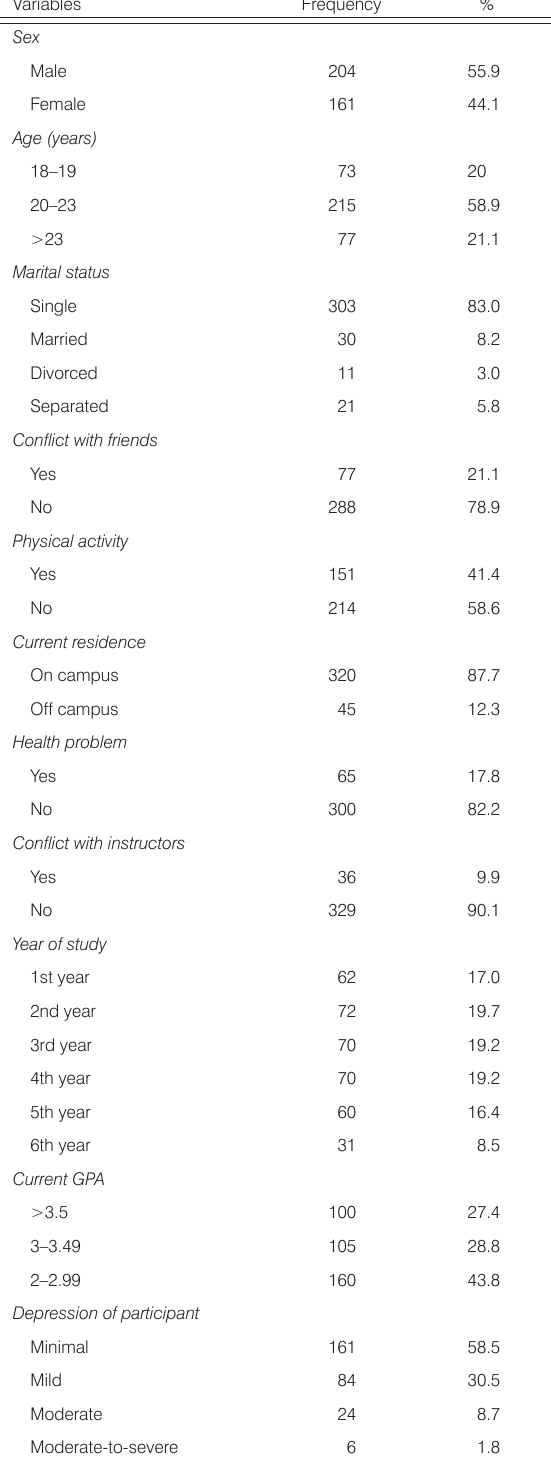
Table 1. Sociodemographic and other characteristics of the students of the Institute of Health of Jimma University in the year 2019 ( N =